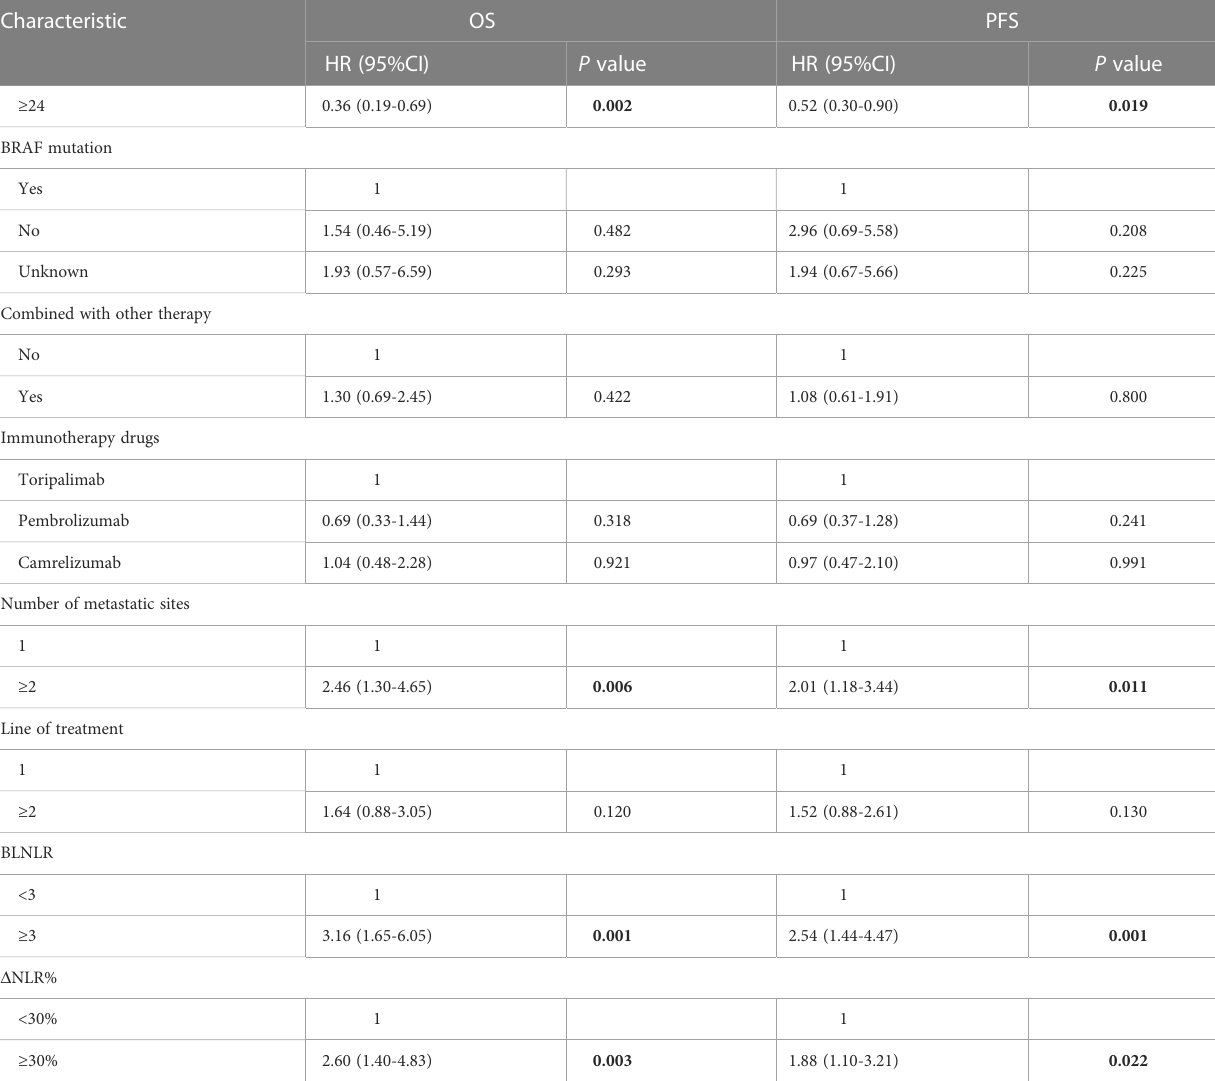
4.82-11.18 months) in the BMI<24kg/m 2 group ( P = 0.001) (Figure 1C). The median PFS of BMI ≥ 24kg/m 2 group was 7 months (95%CI: 3.06-10.94 months) and only 3 months (95%CI: 2.42-3.58 months) in the BMI<24kg/m 2 group ( P = 0.009) (Figure 1G). The median OS of the single organ metastasis group was 17 months (95%CI: 8.63-25.37 months) and only 9 months (95%CI: 5.82-12.19 months) in the multiple organ metastasis group ( P =0.003) (Figure 1D). The median PFS of the single organ metastasis group was 5 months (95%CI: 0.60-9.40 months) and only 2 months (95%CI: 1.36-2.64 months) in the multiple organ metastasis group ( P = 0.004) (Figure 1H).